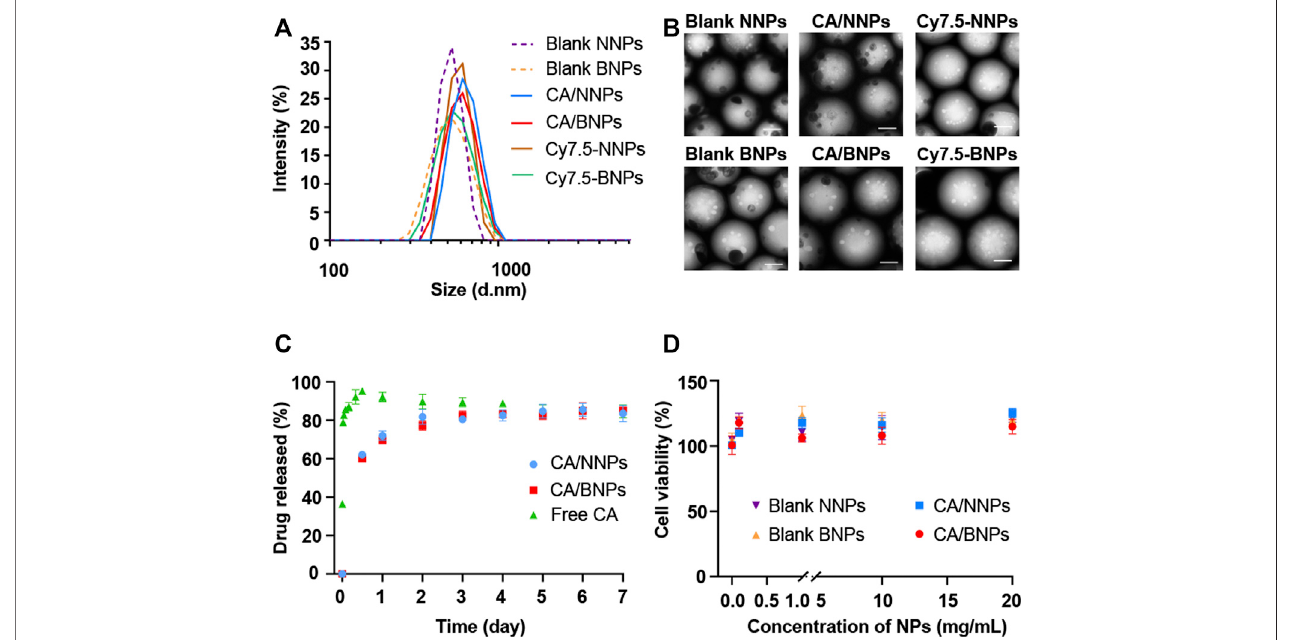
FIGURE2| Invitro nanoparticlecharacterization. (A) Hydrodynamicdiametersofnanoparticleformulations. Dataare means±SD( n =3). (B) TEMimages ofblank NNPs, blankBNPs, CA/NNPs, CA/BNPs, Cy7.5-NNPs,and Cy7.5-NNPs(scale bars:200 nm). (C) In vitro releasepro fi le offreeCA,CA/NNPs, and CA/BNPs. Dataare means ± SD ( n = 3). (D) Cell viability of hFbs incubating with blank NNPs, blank BNPs, CA/NNPs, and CA/BNPs for 24 h in vitro . Data are means ± SD ( n = 4).